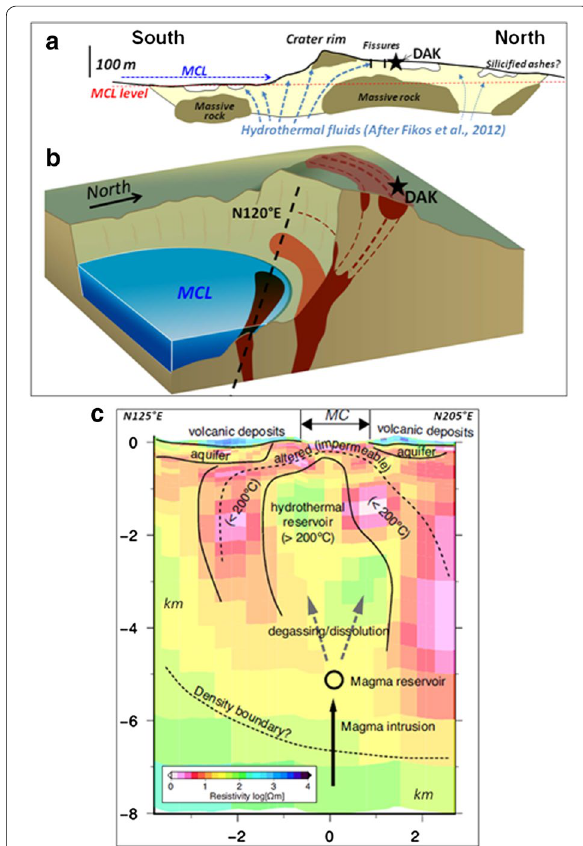
Fig. 3 a Sketch of the geological structure and the hydrothermal circulation deduced from the inversion of Electrical Resistivity Tomography (after Fikos et al. 2012). b General pattern of the geothermal fields in 2010. Brown areas correspond to permanent geothermal fields (after Zlotnicki et al. 2009a). c Inversion of 2D and 3D deep magnetotelluric soundings (after Yamaya et al. 2013; Alanis et al.